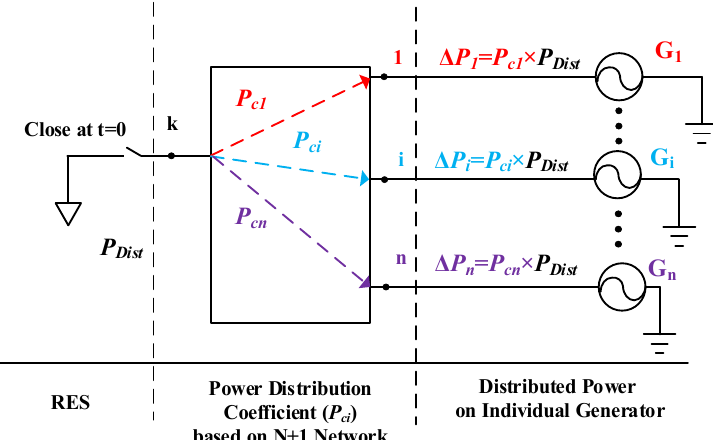
Figure 1. Active power disturbance propagation from renewable energy sources (RES) (i.e., bus k ) to each generator bus.